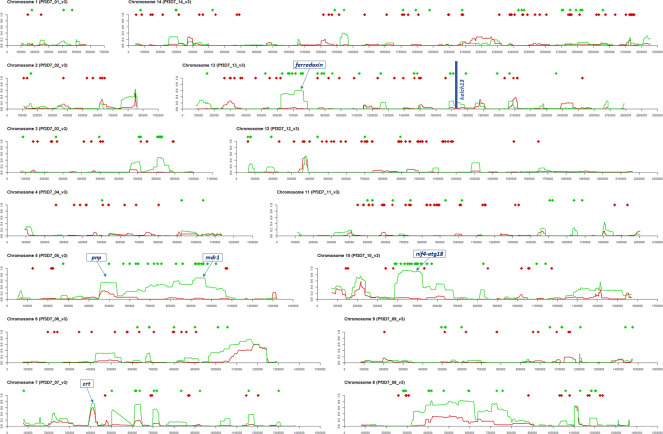
Structure of genetic admixture in Wewak C580Y mutants.Fourteen plots are shown, one per chromosome in the P. falciparum nuclear genome; the x-axis of each plot represents nucleotide positions along the chromosome. At the top of each plot, two rows of diamond markers indicate the position of SNPs that are highly differentiated between the Wewak and Timika populations (FST ≥ 0.3); the marker colour indicates whether the allele present in the Wewak C580Y mutants matches the most common one in Timika (green diamonds) or Wewak (red diamonds). The line charts below the markers show the proportion of sample pairs in the Timika (green lines) and Wewak (red) population that are IDB with the Wewak C580Y parasites at each chromosome position.